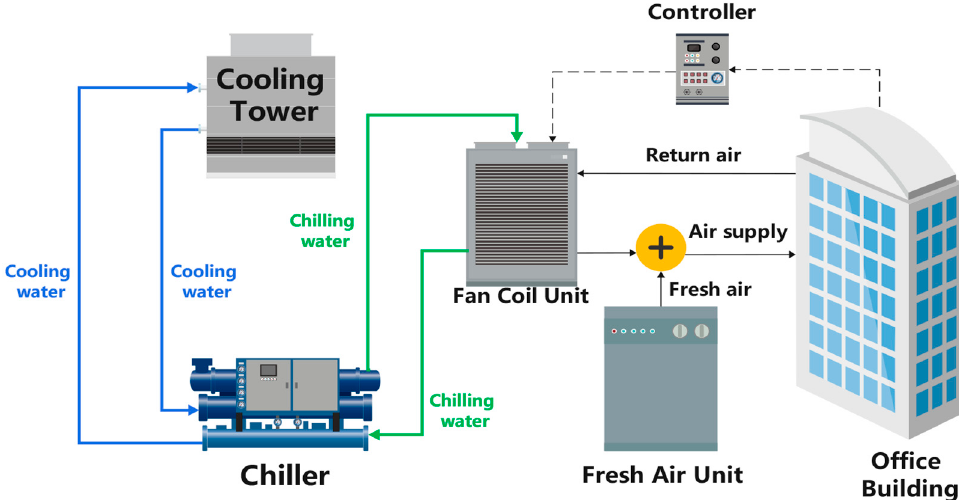
Figure 5. Architectural model in SketchUp.